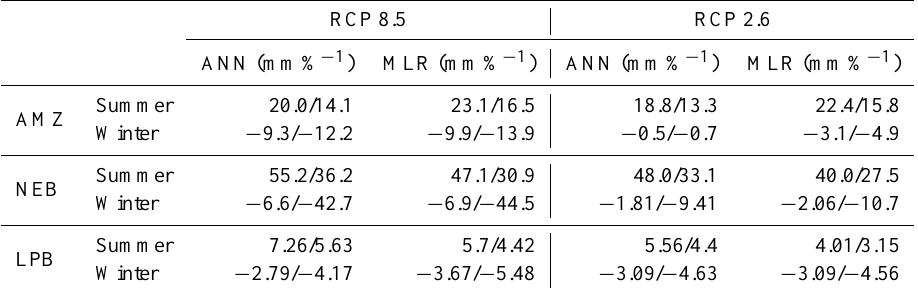
Table 5. Change in monthly precipitation in terms of an increase or decrease by the end of this century (2071–2100) in the scenarios RCP 8.5 and 2.6, in relation to the reference period 1971–1999 (observation), in millimeters per month and